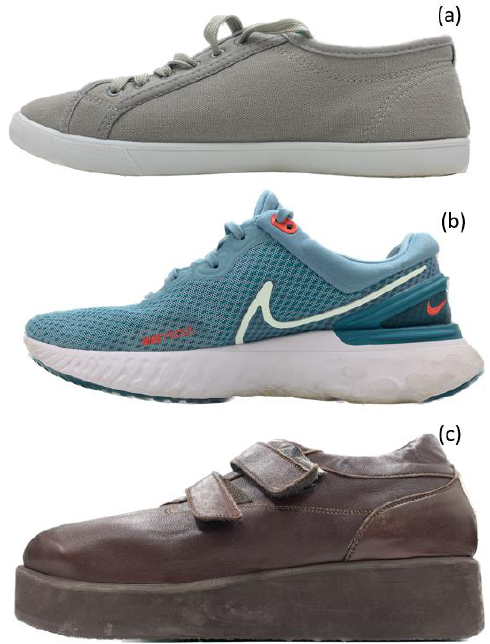
Figure 7. ( a ) Plimsoll with a flat sole, ( b ) trainer as a standard type of footwear used in the experiment and ( c ) therapeutic footwear with rocker features.